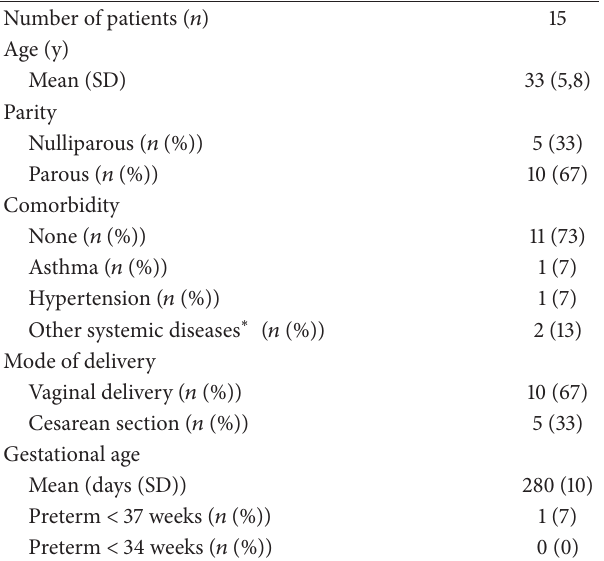
Table 2: Baseline characteristics and pregnancy outcome of preg- nant women with 2009 influenza A/H1N1 infection during preg- nancy whose placentas were